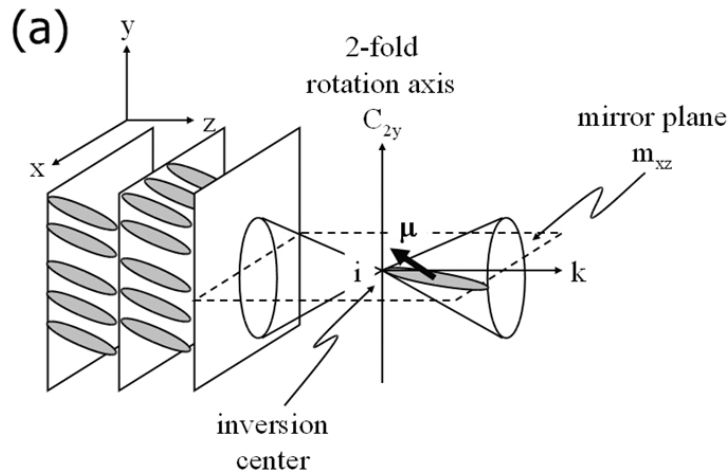
Figure 3. ( a ) Symmetry elements of the achiral SmC phase, explaining the absence of a spontaneous polarization; ( b ) schematic helical superstructure of the chiral SmC* phase ( left ) and associated polarized microscopic image of the equidistant line pattern ( right ). (Reproduced with permission from [8]. Copyright 2003, Wiley-VCH Verlag GmbH&Co.